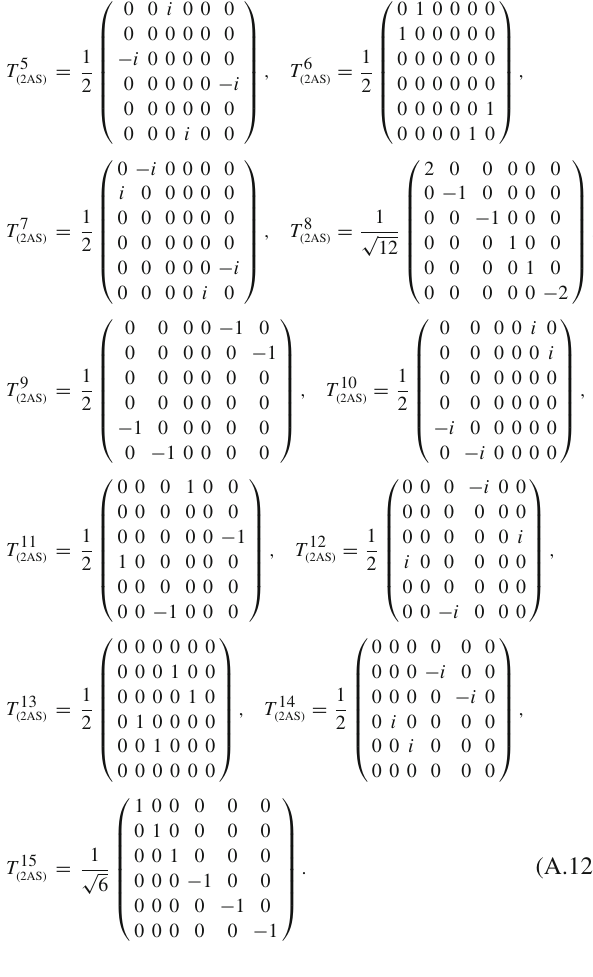
(cid:9) a − (cid:10) and (cid:9) a + (cid:10) are the averages over N ments, respectively the first and the last ones (see Section